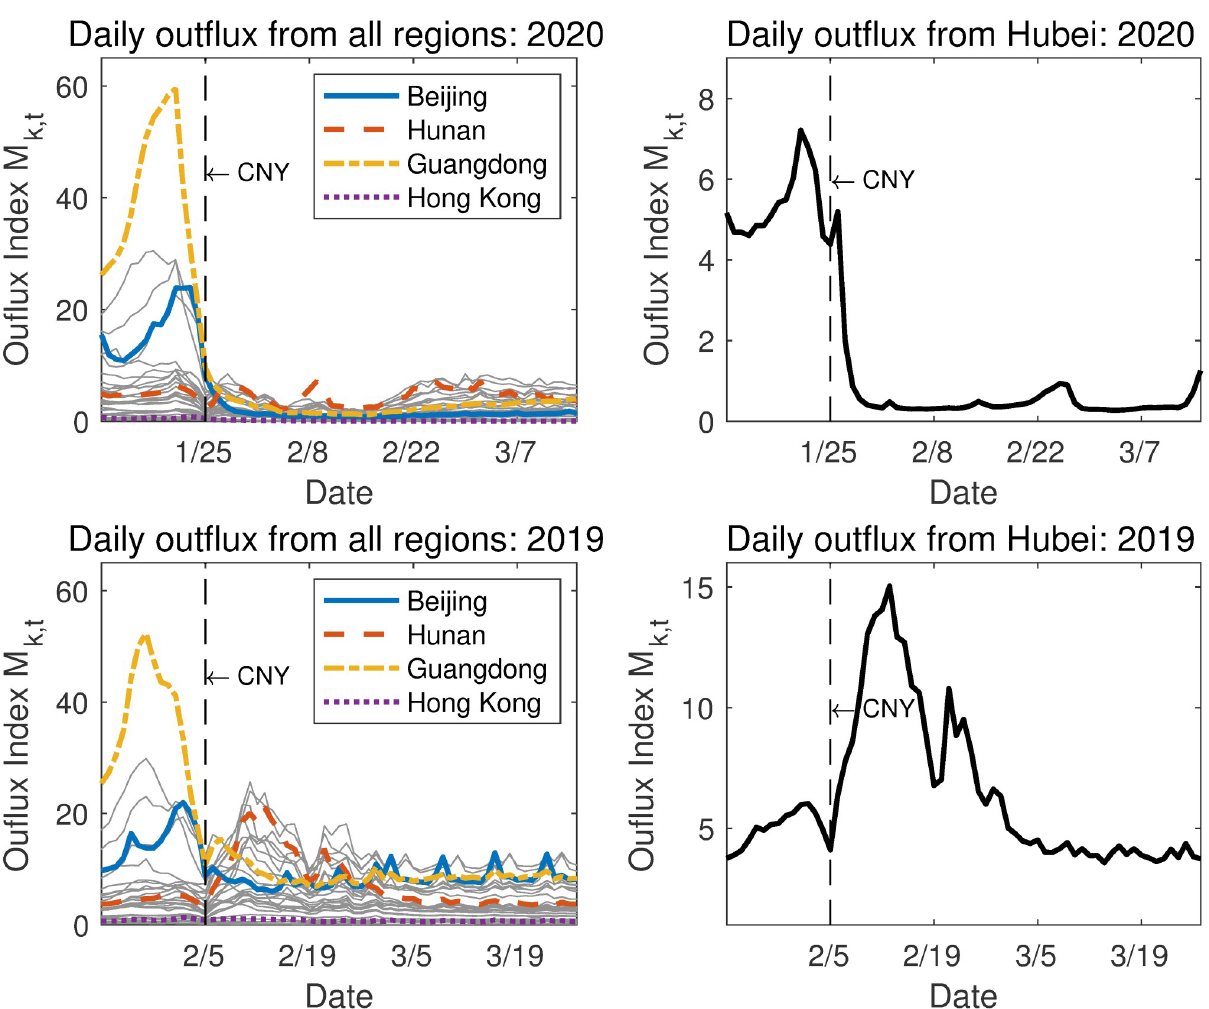
Fig 1. Daily outflux in 2020 and 2019. The two panels on the left column show daily outflux from all regions in 2020 and 2019. The ones on the right column show the outflux only in Hubei. In each panel, a dashed vertical line shows the date of the Chinese New Year (CNY) in 2019 and